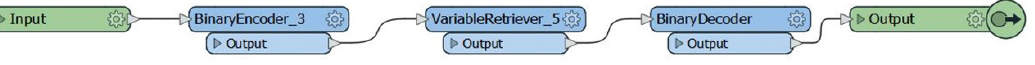
Figure 17. “GetGrandParentID” custom transformer workflow.